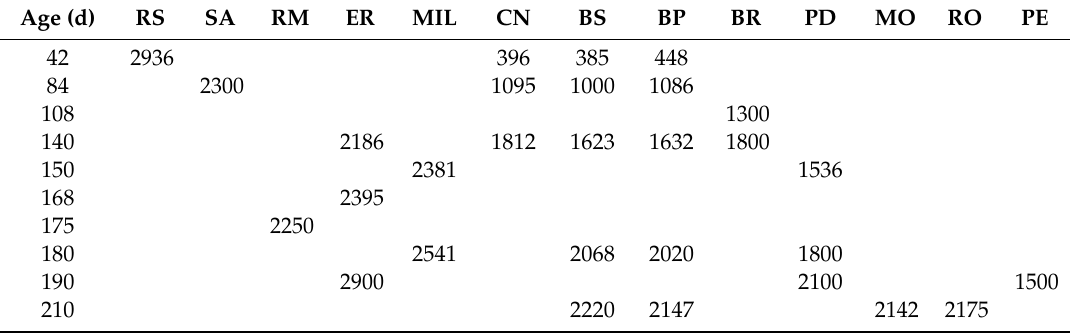
Table 3. Average actual body weight of the Bianca di Saluzzo and Bionda Piemontese chicken breeds during the growing phase: comparison with other breeds / hybrids.